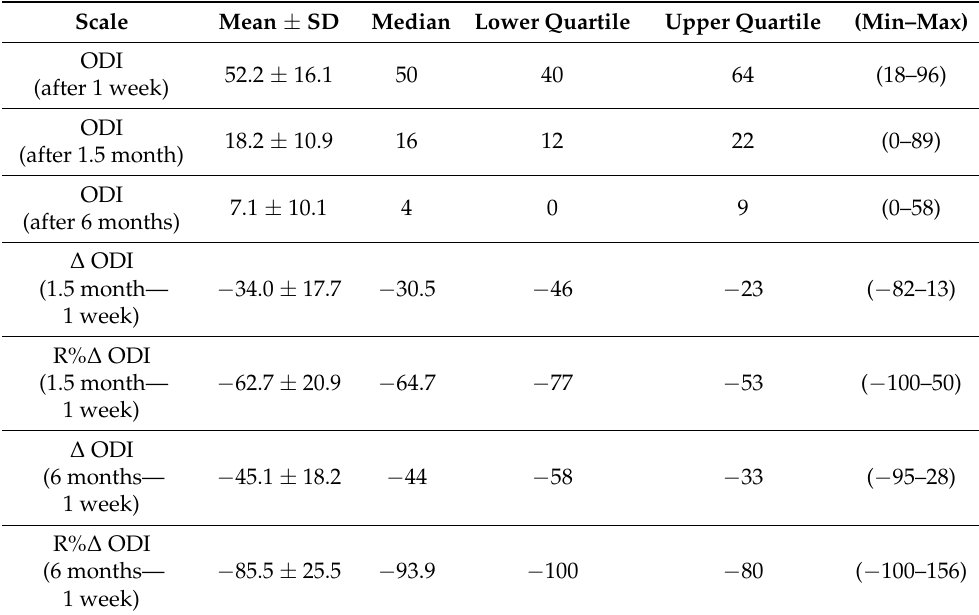
Table 5. Table 3. Disability analysis of patients after hip arthroplasty at defined intervals.